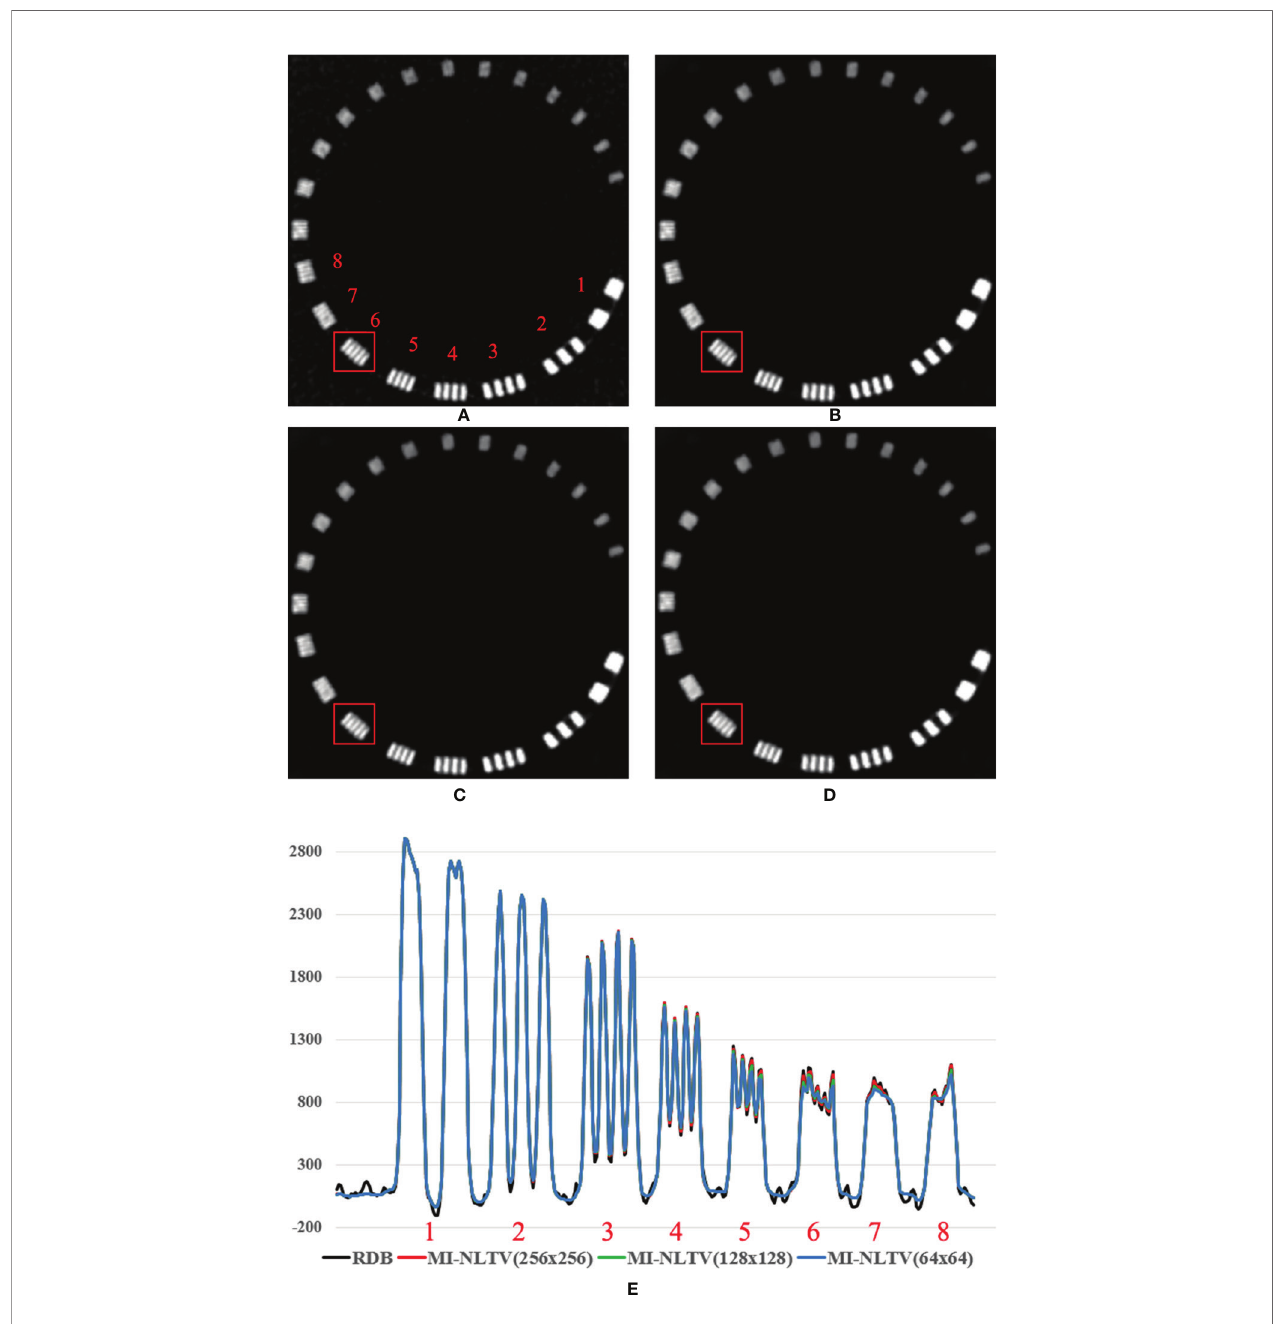
FIGURE 7 | Comparison between the same views of the reconstruction image generated by (A) RDB only and RDB followed by MI-NLTV applying (B) joint histogram bin size of 256 × 256, (C) 128 × 128, (D) 64 × 64, and (E) line pro fi le at the red square using the Catphan ® 503 phantom. These images are displayed at the window settings of (width = 1,500, level = 876) HU.